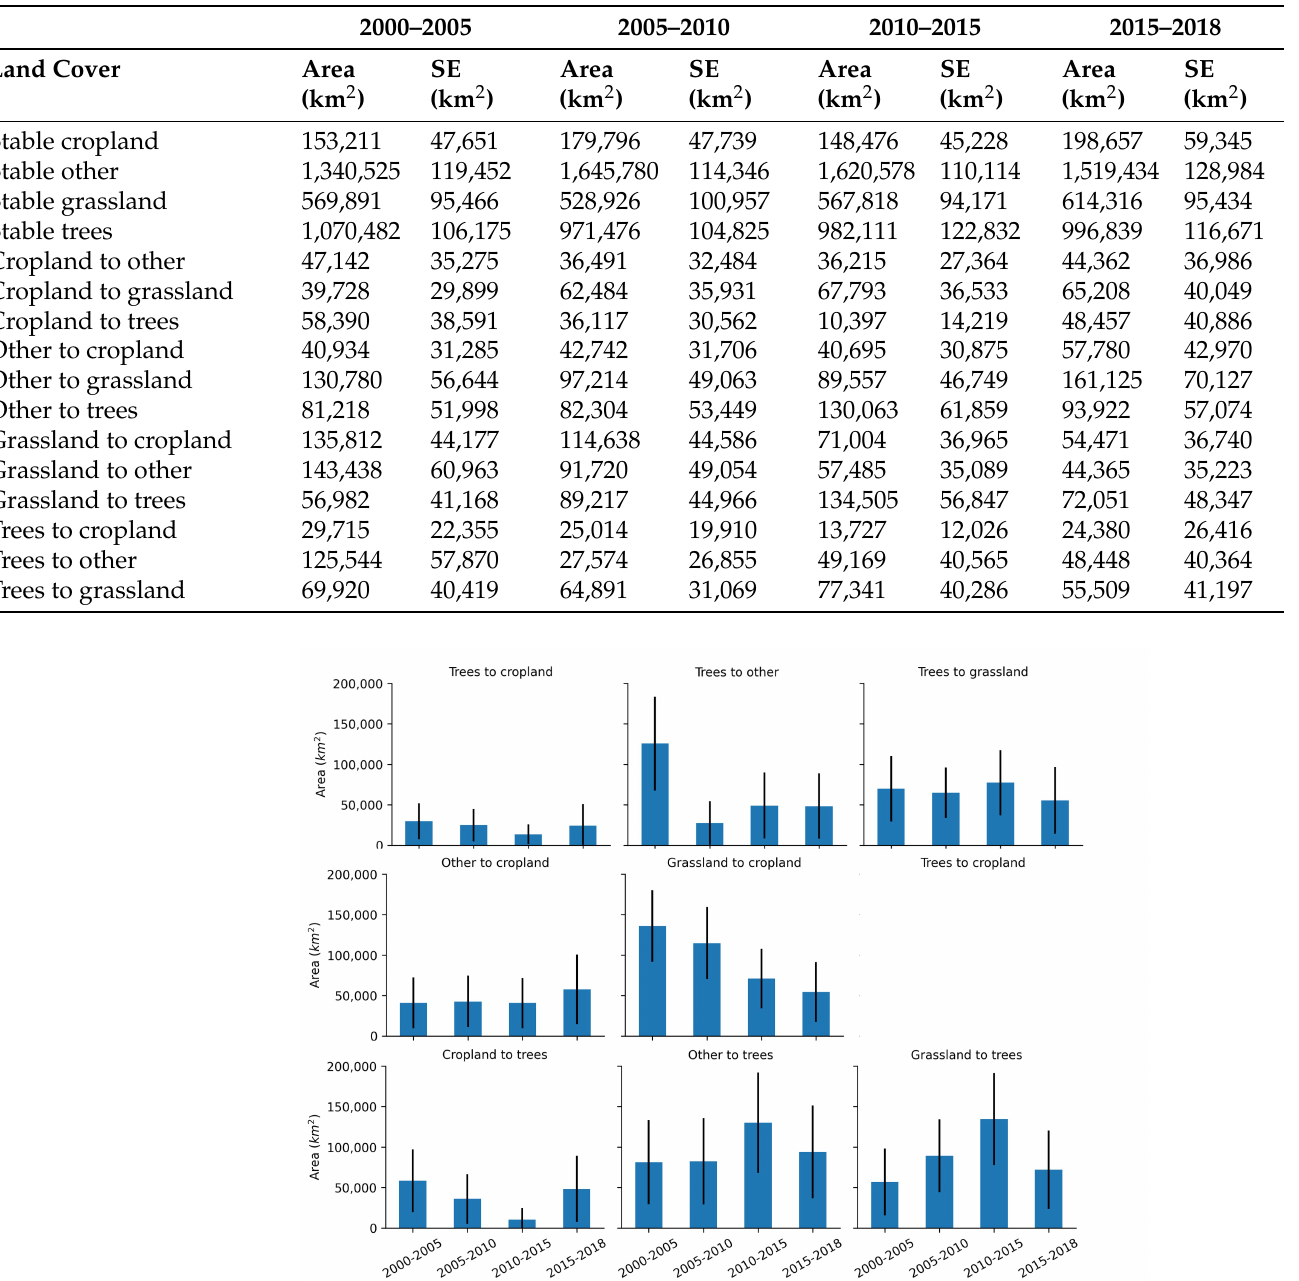
Table 5. Stratified unbiased area estimate and standard error of the error-adjusted area confidence interval (SE) for four different periods assessed in this study.